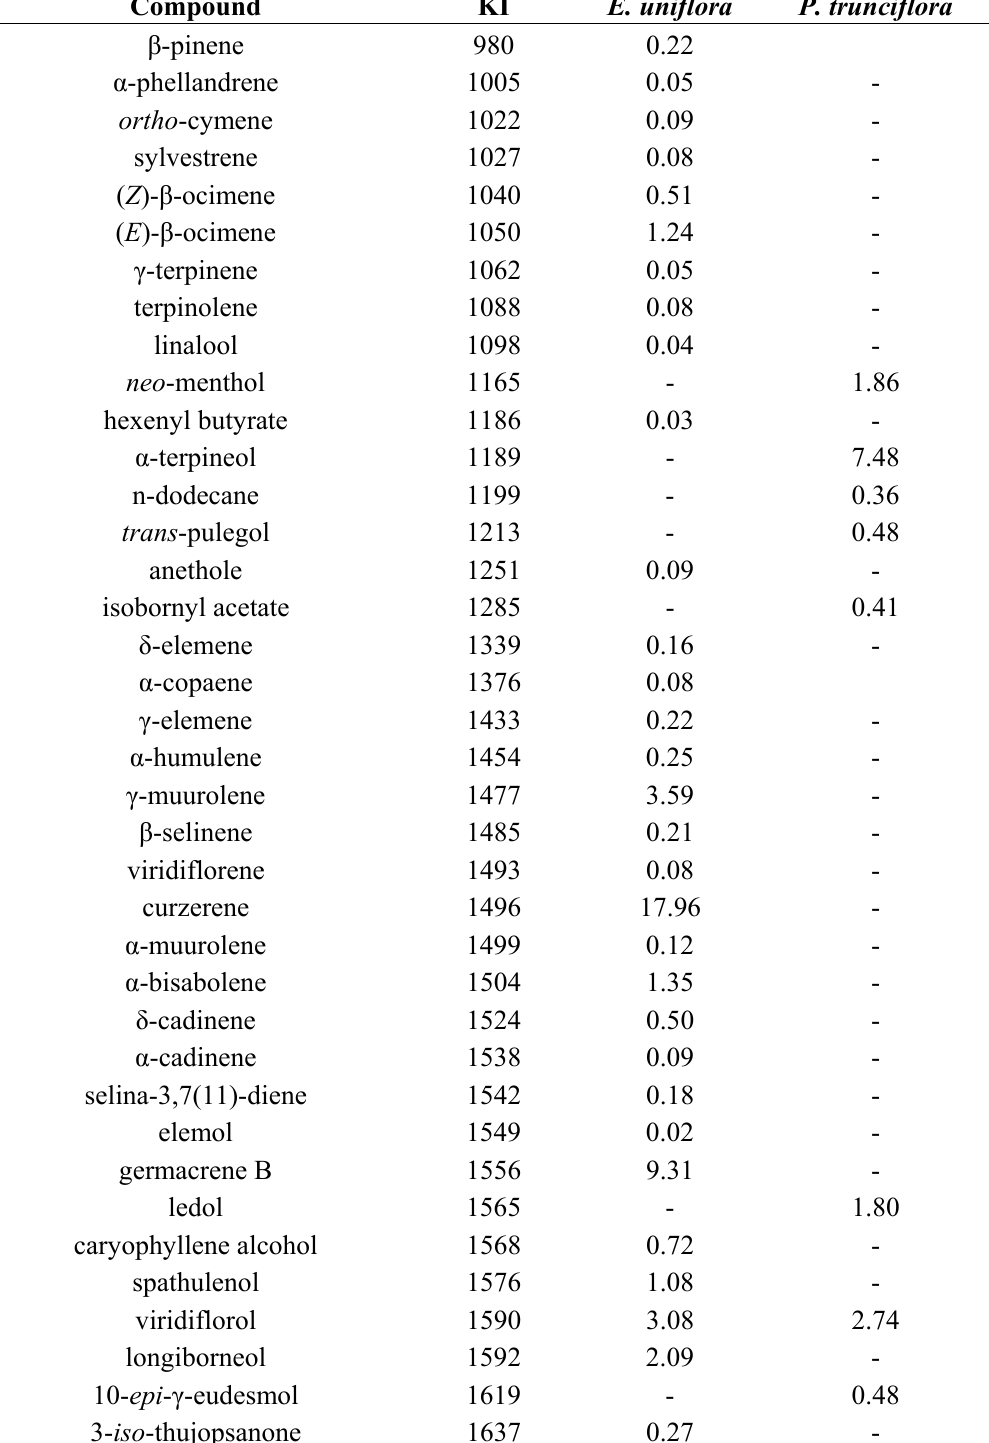
Table 1. Chemical composition of essential oil from leaves of E. uniflora and P. trunciflora